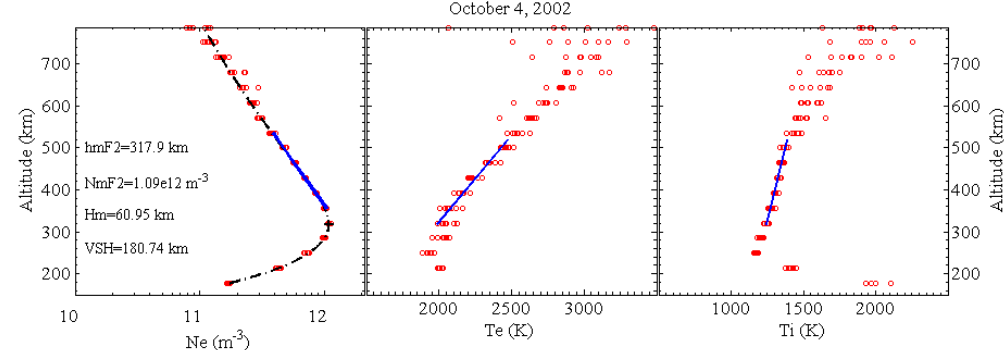
Fig. 2. The Millstone Hill ISR altitude profiles of electron density, N e , and ion and electron temperatures, T i and T e , during a half-hour interval around 17:50 UT on 4 October 2002. At the left panel, the dashed line shows the fit of N e with a Chapman- α profile function, while the solid line shows the exponential fit. The solid lines at the center and right panels show, respectively, the linear fit for the T i and T e